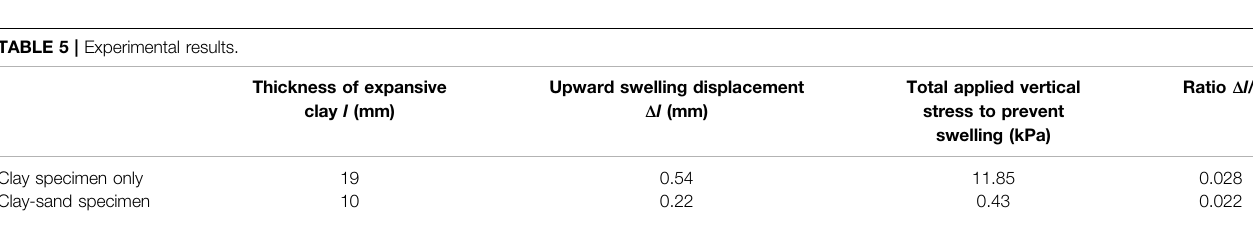
TABLE 5 | Experimental